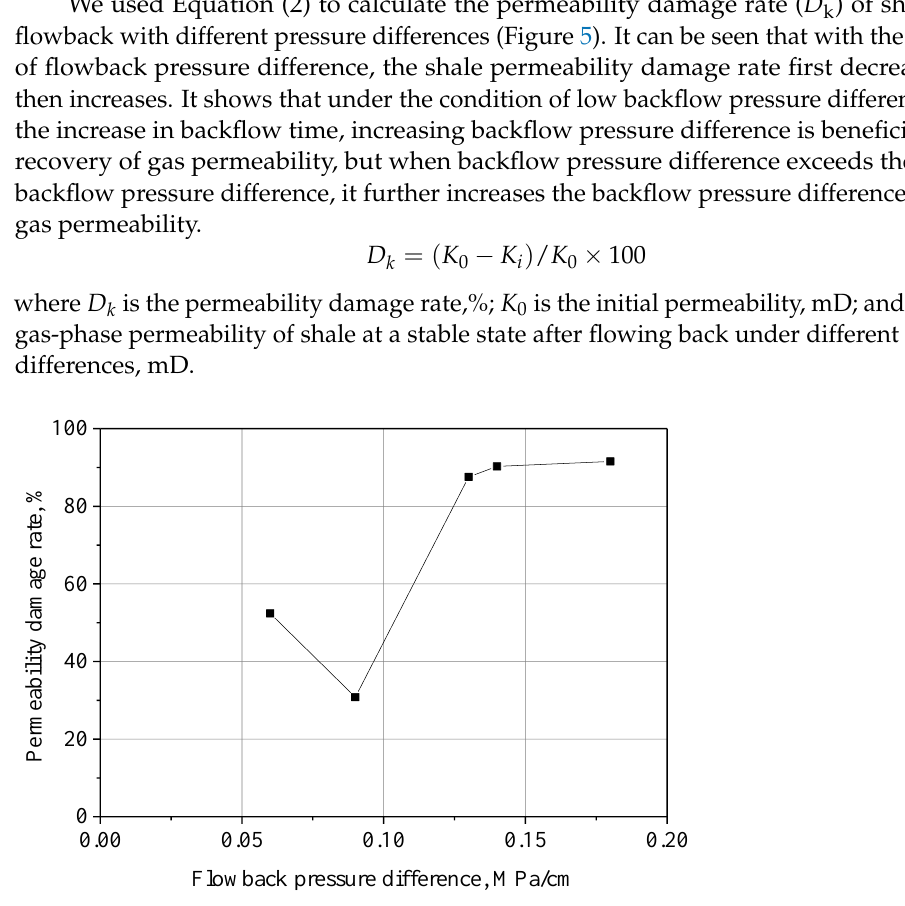
Figure 5. Relationship between flowback pressure difference and permeability of five shale sam- ples.